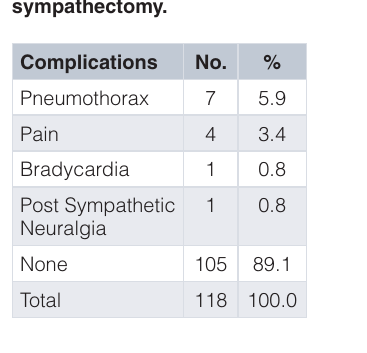
Table 3. Complications of endoscopic thoracic sympathectomy.